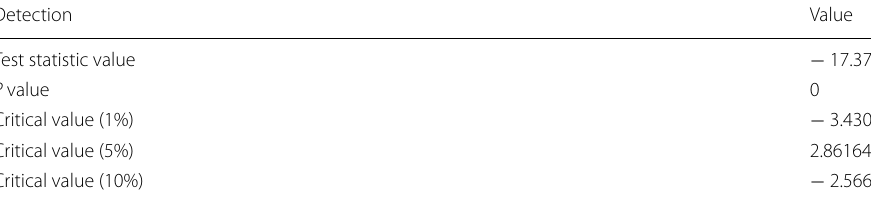
Table 1 The detection result of ADF